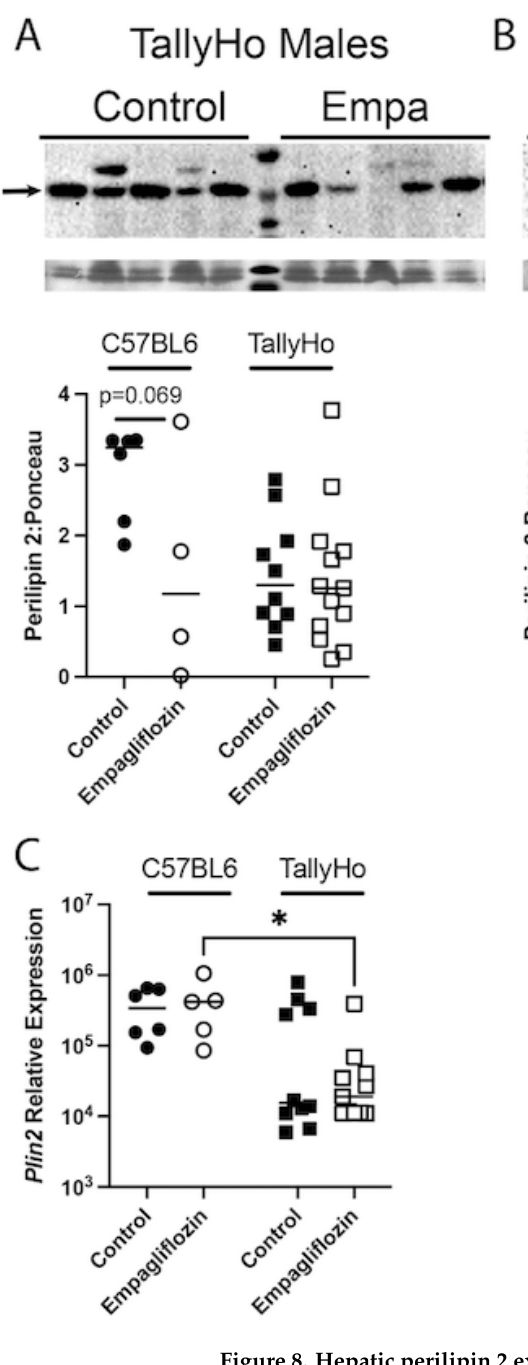
Figure 8. Hepatic perilipin 2 expression is not changed upon Empagliflozin treatment. Perilipin 2 protein expression was measured via immunoblotting in both C57BL6J and TallyHo male ( A ) and female ( B ) livers. Representative blots are shown from TallyHo livers in ( A , B ). Expression was normalized to total protein stain via Ponceau imaging and graphed. ( C ) qPCR for Plin2 , the gene that encodes for Perilipin-2, in control and Empagliflozin-treated male mice. * p < 0.05 between C57BL6J and TallyHo mice.